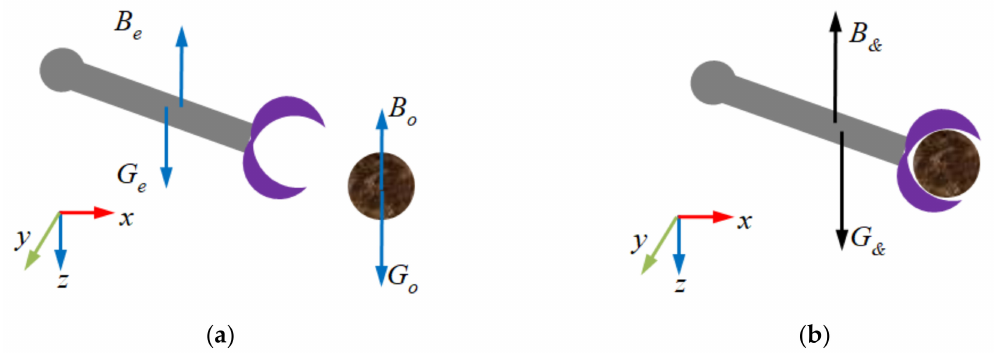
Figure 5. The process of grasping an object of end effector: ( a ) parted; ( b )